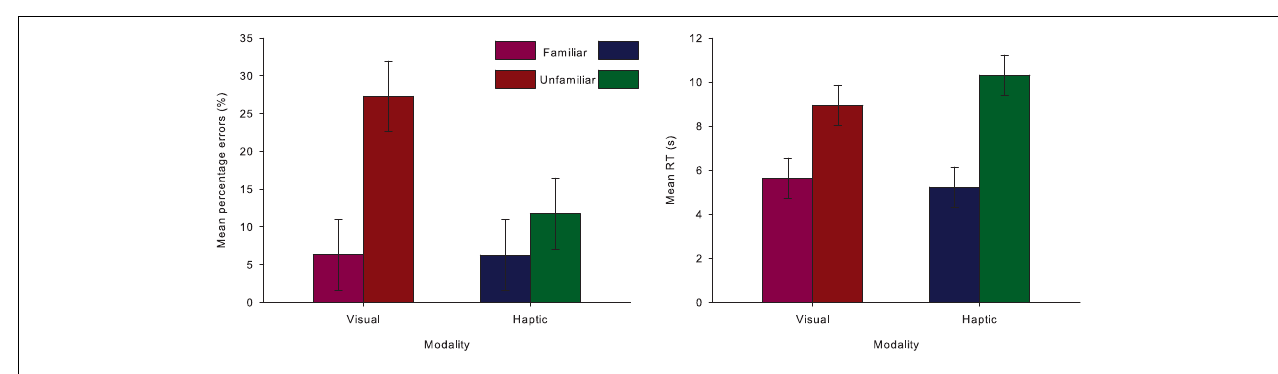
FIGURE 4 | Behavioral data. Percentage of errors and reaction times for correctly identified objects are shown, with error bars indicating